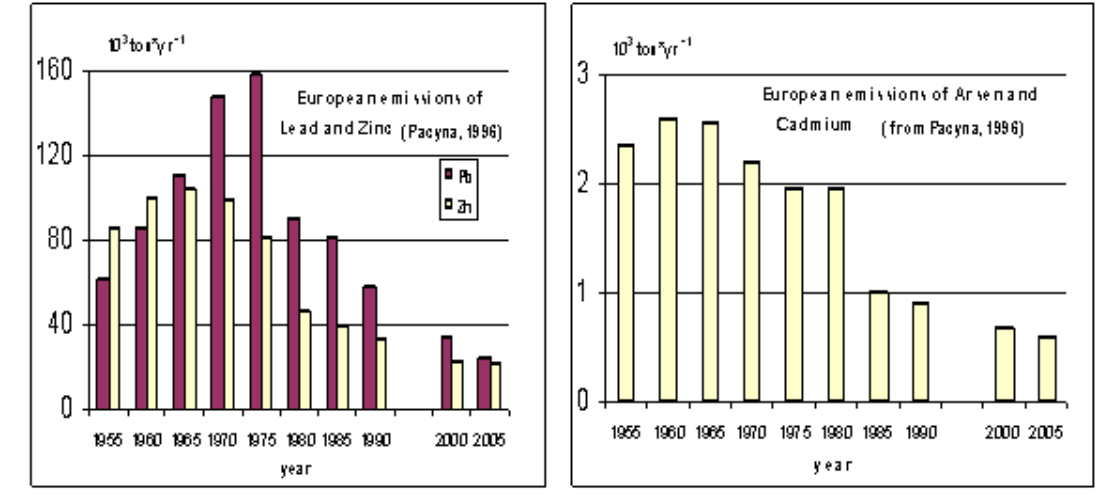
FIGURE 3. Yearly European emissions of Pb, Zn, and Cd shown as average values calculated for ten 5-year periods based on data from [7].